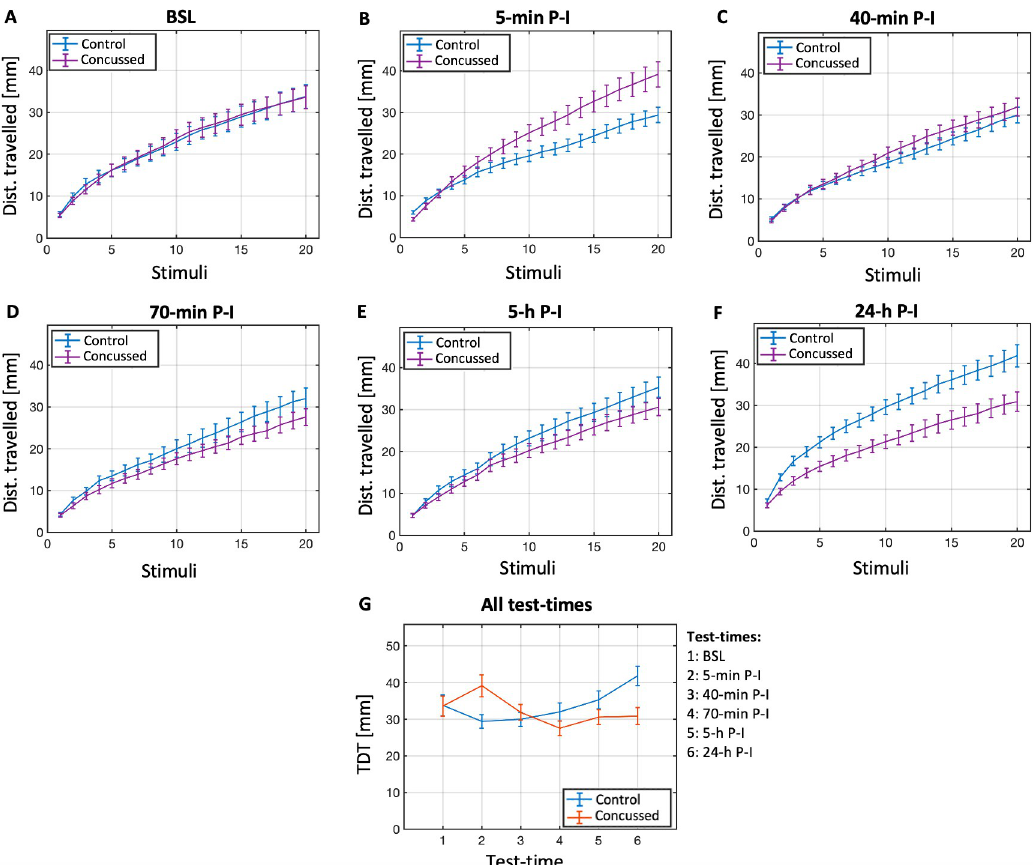
Fig 2. Startle responses over test-times. Mean distance travelled (+/-1 SE) at each stimulus, for both groups (N = 72, each), at each time point (A-F). Total distance travelled after 20 vibratory stimuli (M +/-1 SE) for both groups (N = 72, each) at each time point (G). A 2x6 mixed ANOVA (N control = 72, N concussed = 72) was run. No significant main effect of group (F(1,142) = 0.499, p > 0.05) on the mean TDT 20 was found, with controls (M = 33.724, SE = 1.446) and concussed (M = 32.28, SE = 1.446) performing similarly overall. A significant main effect of time (F(4.365,619.792) = 2.559, p = 0.033) was observed, although without significant differences at the pairwise level. The effect of time was different for the control and concussed group (G), as confirmed by a significant interaction between group and time (F(4.365, 619.792) = 5.644, p < 0.001). The interaction effect was then broken down through two one-way repeated-measures ANOVAs, which analysed the effect of time (six levels) for the control and concussed groups separately. For the control group (N = 72) there was a significant effect of time (F(4.137,293.712) = 4.825,p < 0.001). Pairwise comparisons further indicated that the mean TDT 20 was significantly higher at time 6 (24-h P-I, M = 41.885, SE = 2.655) than at time 2 (5-min P-I, M = 29.406, SE = 1.859) with p < 0.001, at time 3 (40-min P-I, M = 29.975, SE = 1.898) with p = 0.004. A significant effect of time (F(4.069,288.933) = 3.403, p = 0.009) was found also for the concussed group, whose mean TDT 20 was significantly lower at time 4 (70-min P-I, M = 27.547, SE = 2.018) compared to time 2 (5-min P-I, M = 39.142, SE = 3.027) with p < .001. No additional statistical differences at pairwise levels were